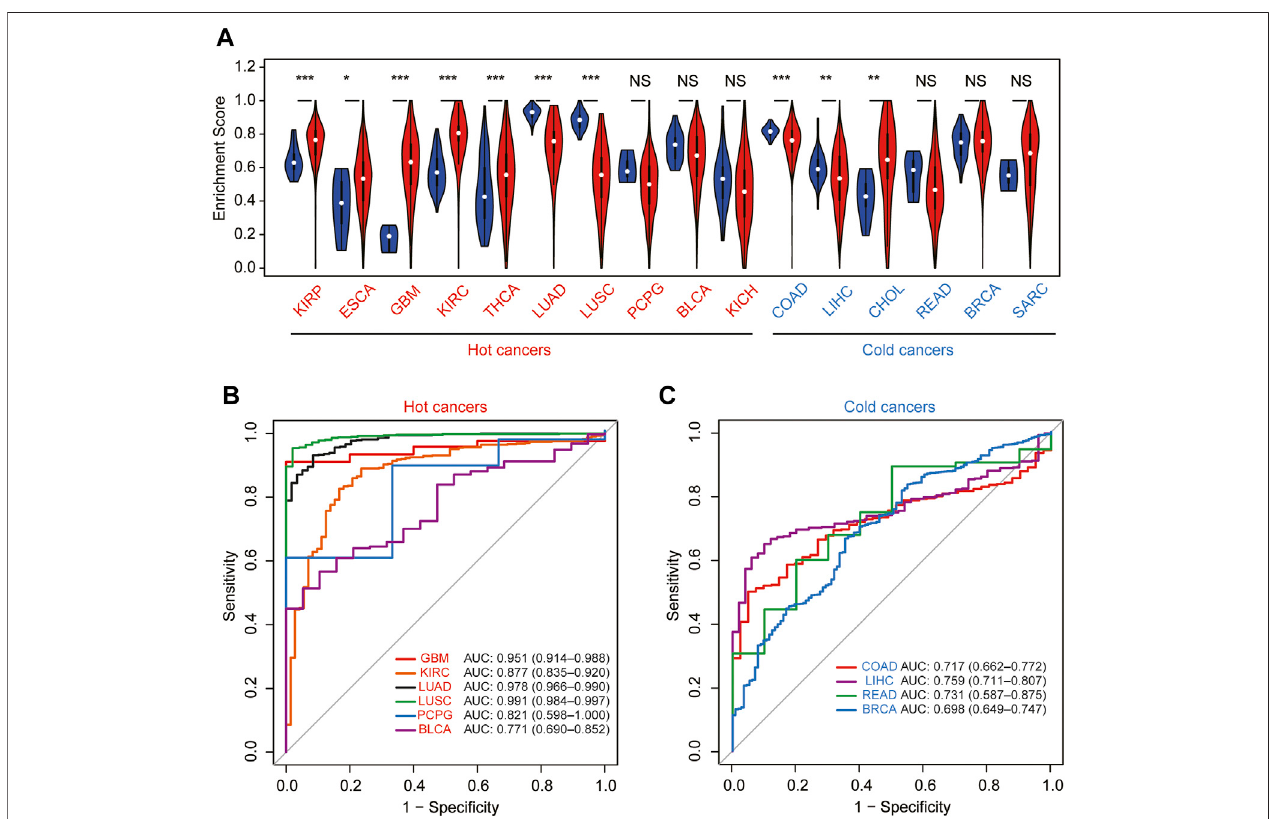
FIGURE 7 | Diagnostic value of the module – gene of ferroptosis in pan-cancer. (A) Differential expression of the enrichment score between normal and tumor tissues in 16 types of cancer. Cancers were further divided into hot-cancers and cold-cancers based on the immune activation and presented in red and blue colors, respectively.* p < 0.05;** p < 0.01;and*** p < 0.001wascalculatedusingtheWilcoxonrank-sumtest.Thereceiveroperatingcharacteristiccurve(ROC)fortheprediction of normal and tumor samples using the enrichment score in hot-cancers (B) and cold-cancers (C) .